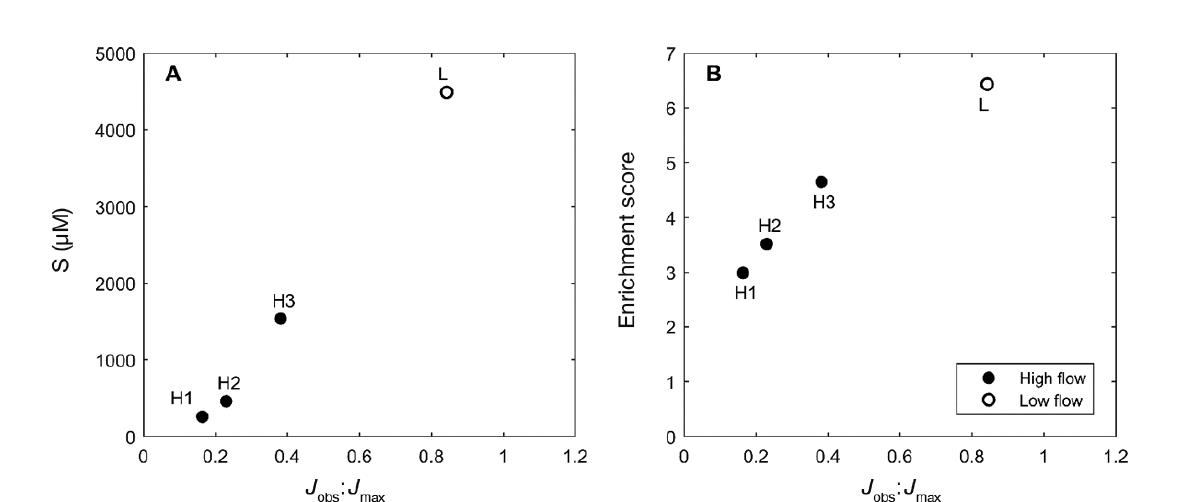
Fig. 9. (A) Sediment sulphide concentration (S) and (B) enrichment score plotted against ratio of observed benthic oxygen flux to theoretical maximum flux ( J obs : J max ), for sites H1, H2, H3, and